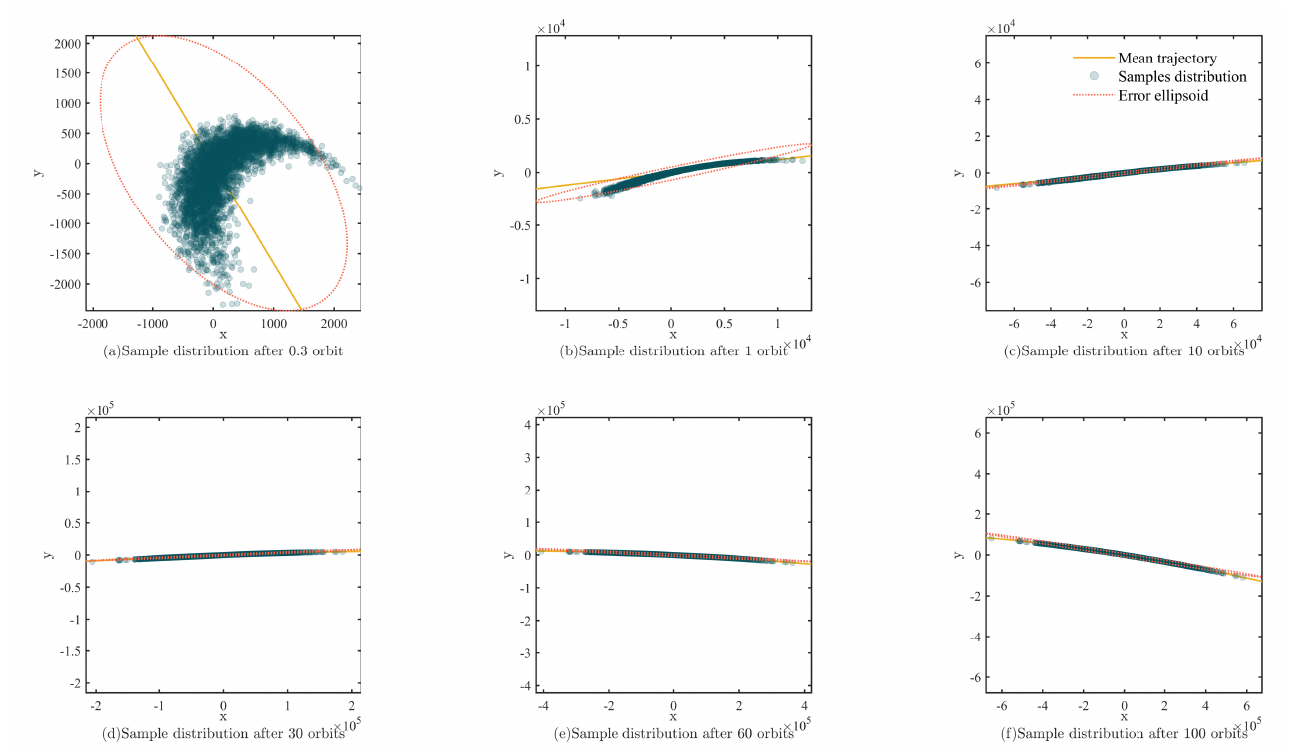
Figure 3. Position distribution and 3- σ error ellipse projection on the x - y